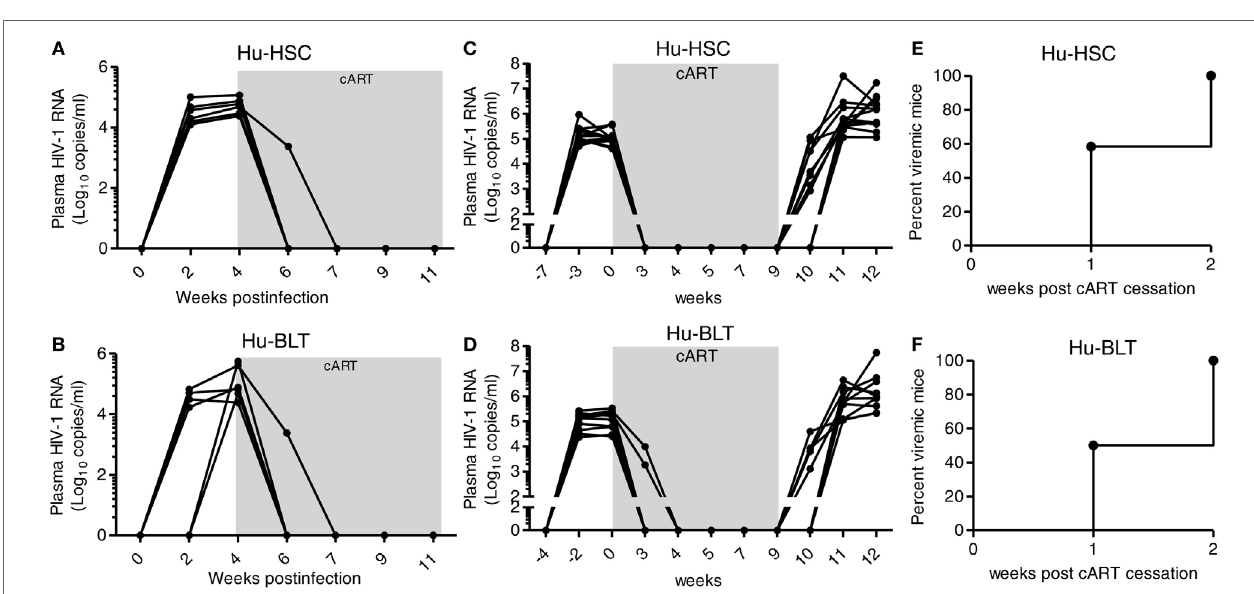
FigUre 7 | Similar efficacy of combined antiretroviral therapy (cART) response in HIV-1-infected NRG-hu HSC and NRG-hu Thy/HSC mice. (a,B) NRG-hu HSC ( n = 6) and NRG-hu Thy/HSC mice ( n = 7) reconstituted with HSCs ± thymus from the same donor were infected with HIV-1 and treated with cART from 4 to 11 weeks postinfection. HIV-1 genomic RNA levels in the plasma were detected at indicated time points. (c,D) A different cohort of NRG-hu HSC ( n = 12) and NRG-hu Thy/HSC mice ( n = 10) were infected with HIV-1 and treated with cART for 9 weeks. HIV-1 genomic RNA levels in the plasma were detected before and after cART discontinuation at indicated time points. The broken horizontal line indicates the limit of detection (400 copies/ml). (e,F) Kinetic analysis of HIV-1 rebound post-cART cessation. Shown (c–e) are combined data from n = 12 (NRG-hu HSC) and n = 10 (NRG-hu Thy/HSC) mice.